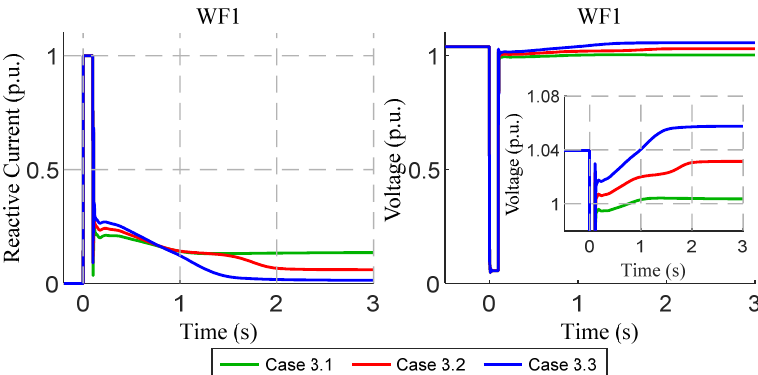
Figure 23. L3 small and large industrial motors’ speeds and terminal voltages: influence resulting Figure 22. WF1 reactive current output and terminal voltage following different voltage/reactive from voltage/reactive current hysteresis tuning. current hysteresis tuning.